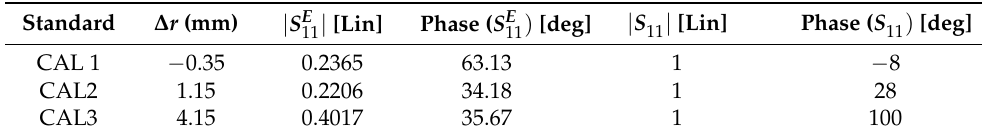
Table 2. Free-space electrical standards used for calibration—f = 10 GHz. Standard